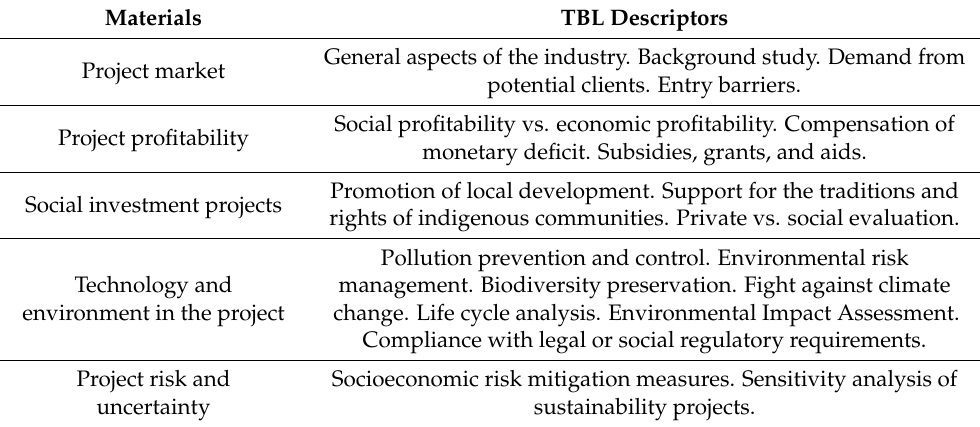
Table 1. Basic descriptors to achieve a project manager’s TBL competences during the evaluation